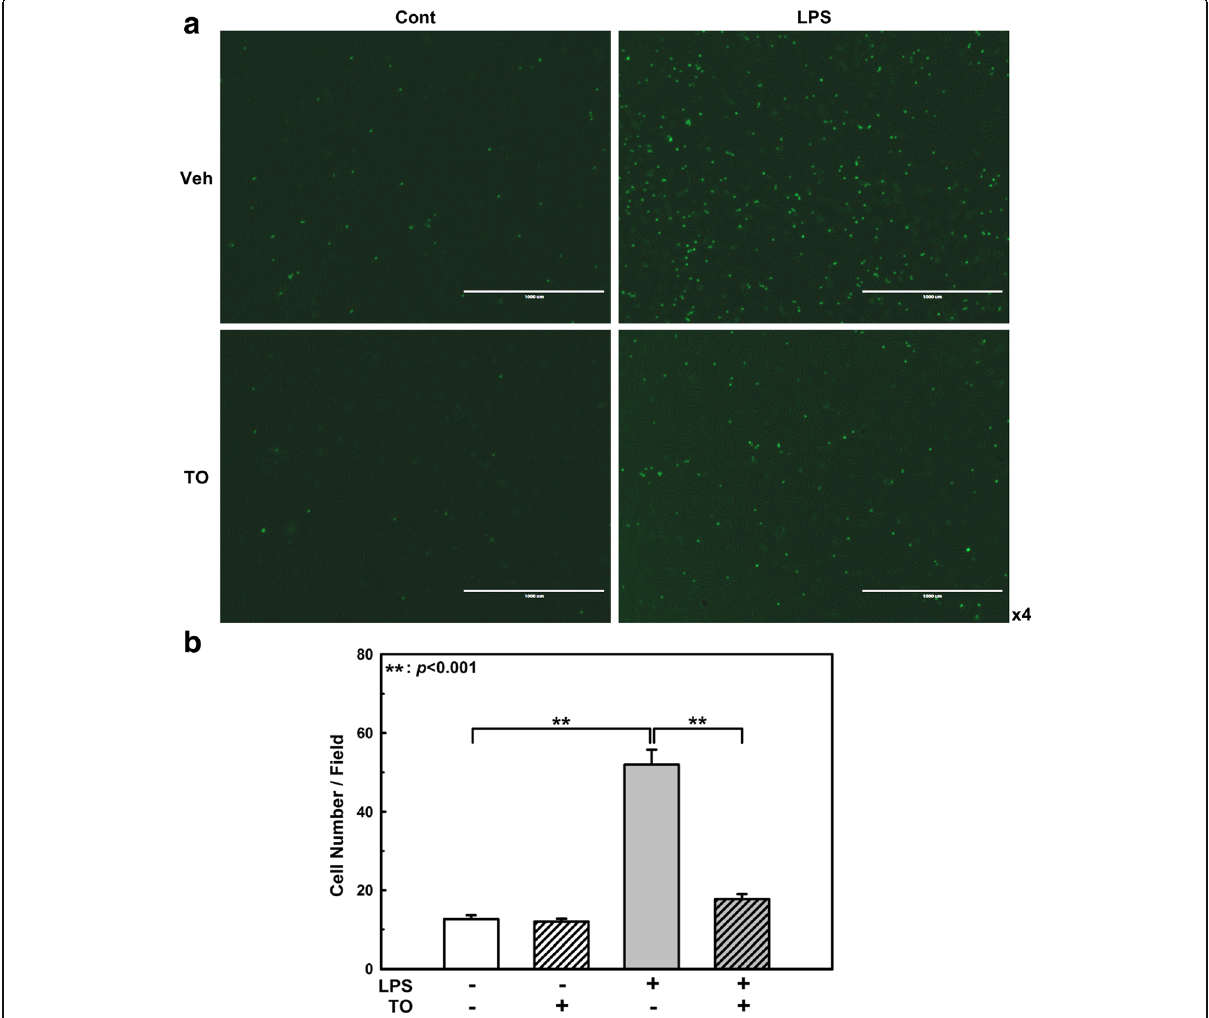
Fig. 2 Effect of the Taraxacum officinale (TO) methanol extract on LPS-induced monocyte adhesion to HUVECs. HUVECs were pretreated with TO extract (100 μ g/ml) for 1 h, and then stimulated with 1 μ g/ml LPS for 24 h. Adhesion of fluorescent THP-1 monocytes was photographed by fluorescence microscopy ( a ) and analyzed ( b ). Scale bars: 1000 μ m. Results shown are the mean±SE of 3 independent experiments. ** p <0.01 vs LPS only